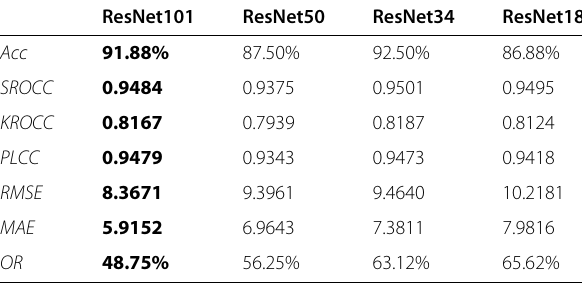
Table 12 Comparison of ResNet degradation results